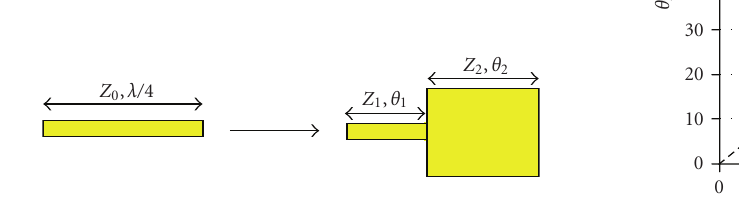
Figure 3: Conventional one-section BSF with two resonators structure.